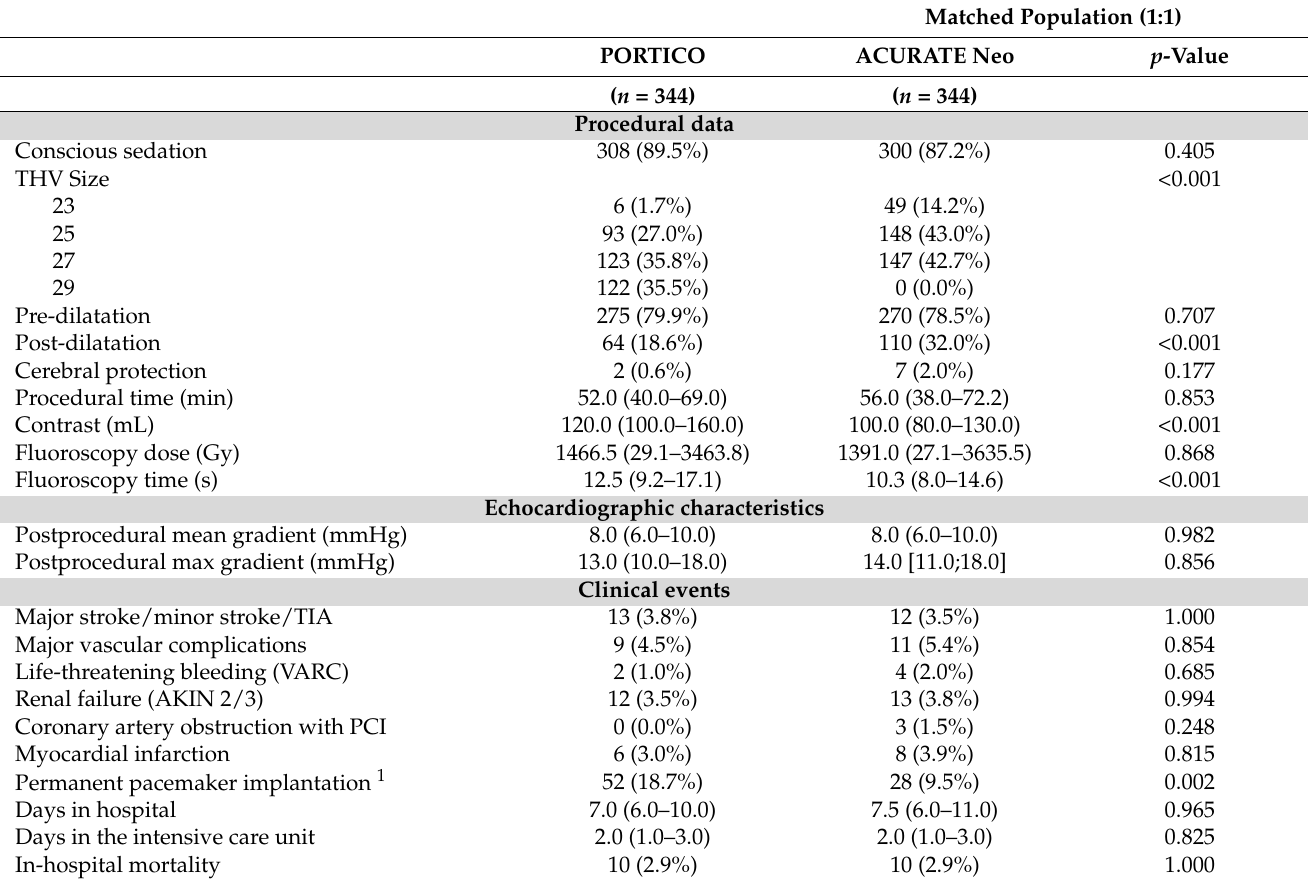
Table 2. Procedural characteristics and in-hospital complications of the patients treated with POR- TICO and of the entire population and the matched population treated with ACURATE